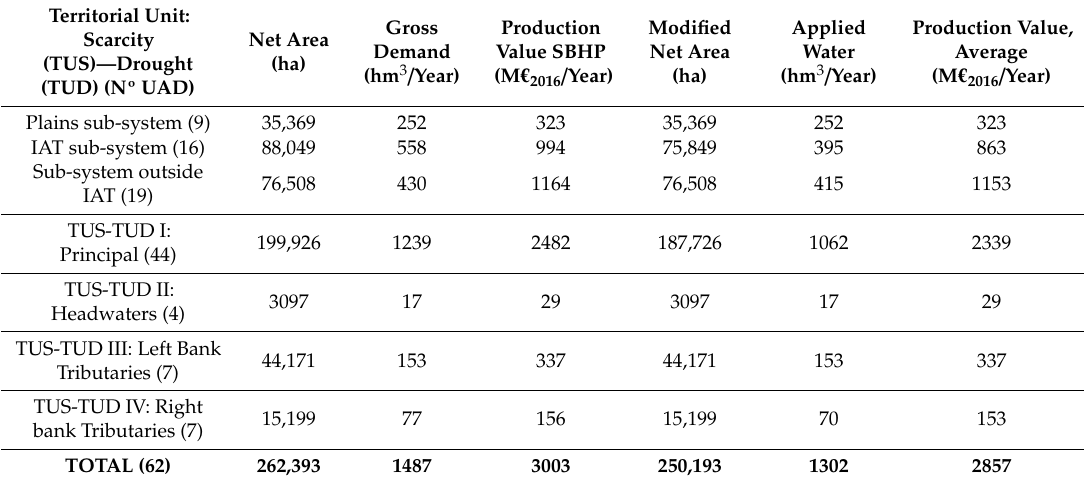
Table 4. Production Value SBHP 2015 / 21 and average. Source: SBHP 2015 / 21. Own elaboration.